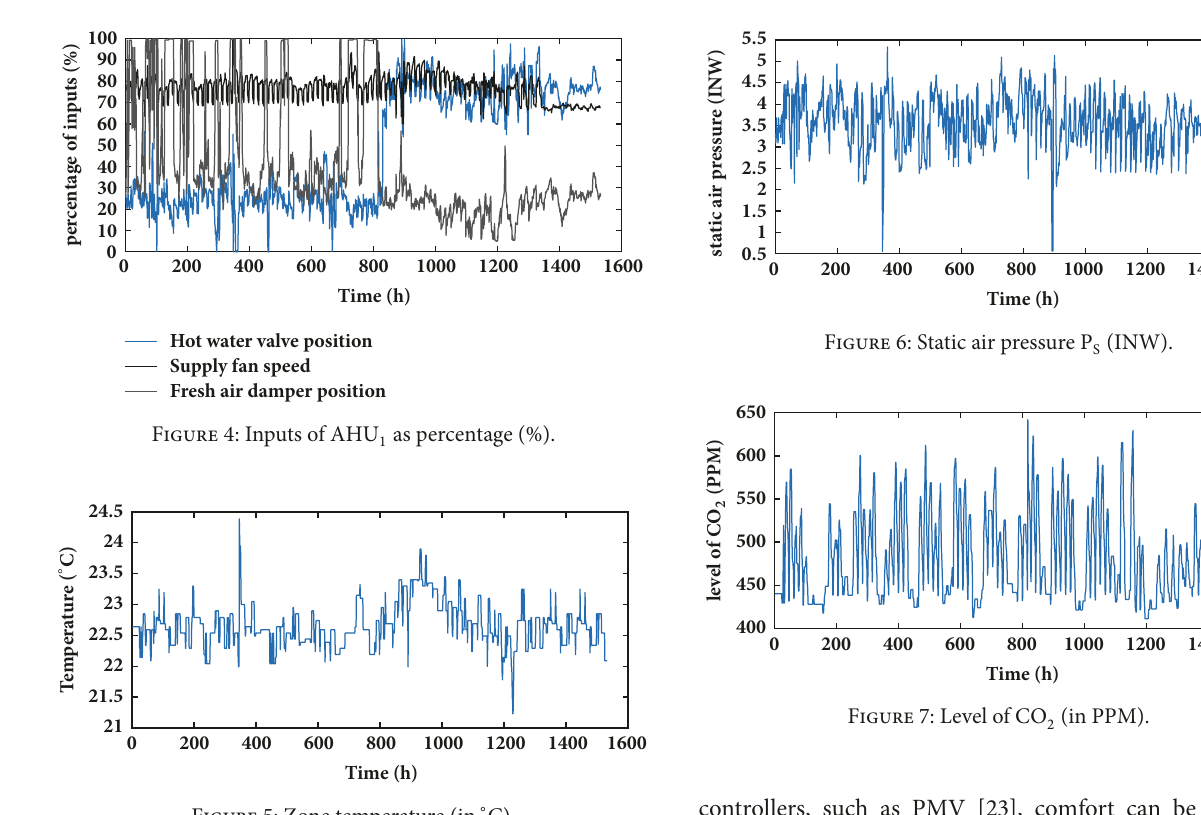
Figure 5: Zone temperature (in ∘ C).